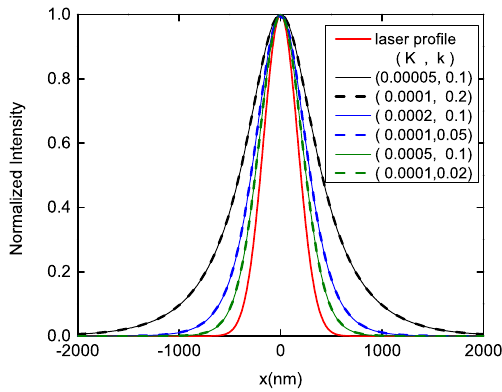
Figure 9. Normalized stationary excitation distribution in a B850 chain with different decay rates K and transfer rates k . The first parameter in the bracket is the value of the decay rate and the second one is for the transfer rate. Both K and k are in units of ps − 1 . The solid red line is the excitation laser profile which is centered at x = 0 and has a full width of half maximum (FWHM) of 400 nm. The other three solid lines are the results with the same k and dashed lines are those with the same K . Each pair of solid and dash lines with the same color have the same K / k